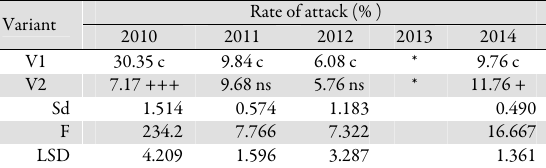
Table 2. Rate of B. jaapii (cherry leaf spot) attack Variant